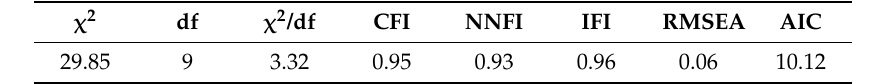
Table 4. Confirmatory factor analysis (CFA) results of the proposed lifestyle evaluation